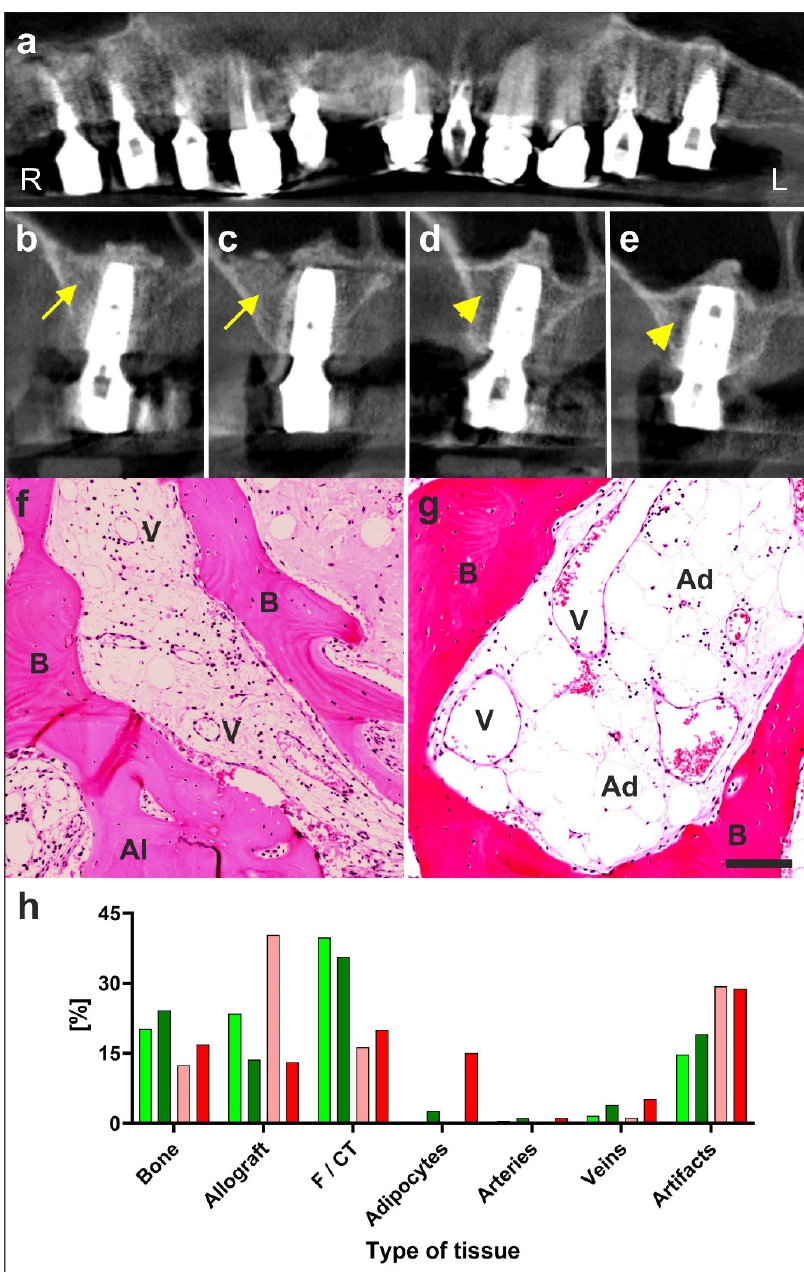
Figure 4. Example of regeneration of bone with UA-ADRCs (modified from [7]). Details are provided in the main text. ( a – e ) digital volume tomography radiographs taken 1 year after the placement of implants and 20 months after guided bone regeneration-maxillary sinus augmentation. Panel a provides a panoramic view; Panels ( b – e ) show detailed views on selected regions. With the application of unmodified autologous adipose-derived regenerative cells (UA-ADRCs) the bone around the implants in regions B and C appears larger in area and denser (yellow arrows in (b,c)) than without the application of UA-ADRCs in ( d , e ) (yellow arrowheads in ( d , e )). ( f , g ) Photomicrographs of bone biopsies taken at six weeks (W6) post treatment with application of cells ( f ) or without cells ( g ). ( h ) Results of histomorphometric analysis of bone biopsies taken at W6 (light green and orange bars) and W34 (dark green and red bars) post treatment with application of cells (green bars) or without cells (orange and red bars). Abbreviations: R, right; L, left; B, bone; Al, allograft; V, vein; Ad, adipocyte; F/CT, fibrin and connective tissue. With cells there was considerably more bone and connective tissue formed already at six weeks than was achieved without cells even after six months. The scale bar in g represents 100 µ